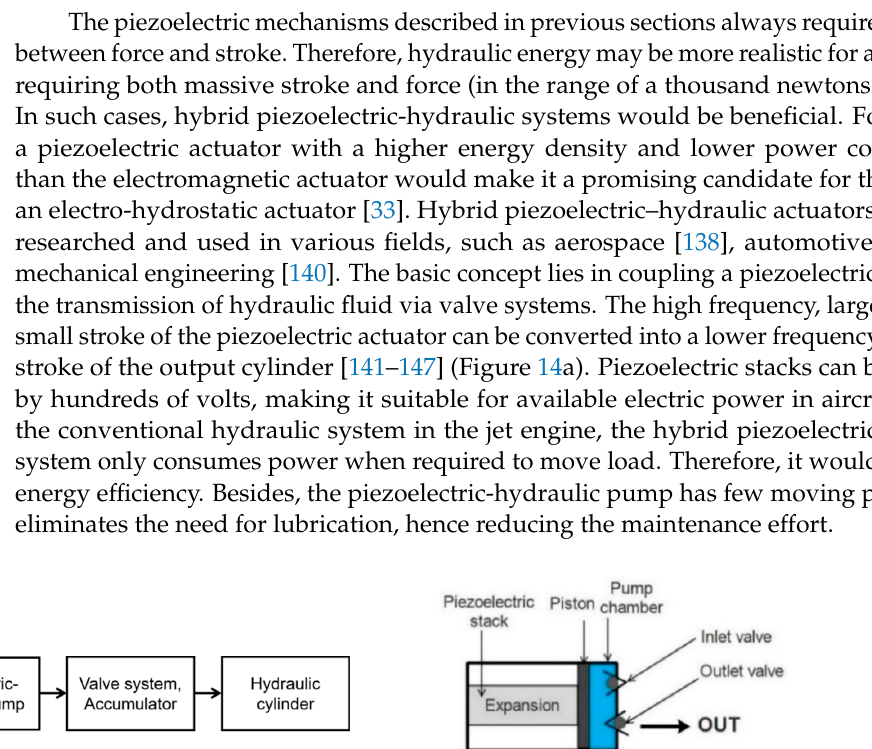
Figure 13. Working principle of the piezoelectric-based ultrasonic actuators: ( a ) standing wave; ( b ) traveling wave.